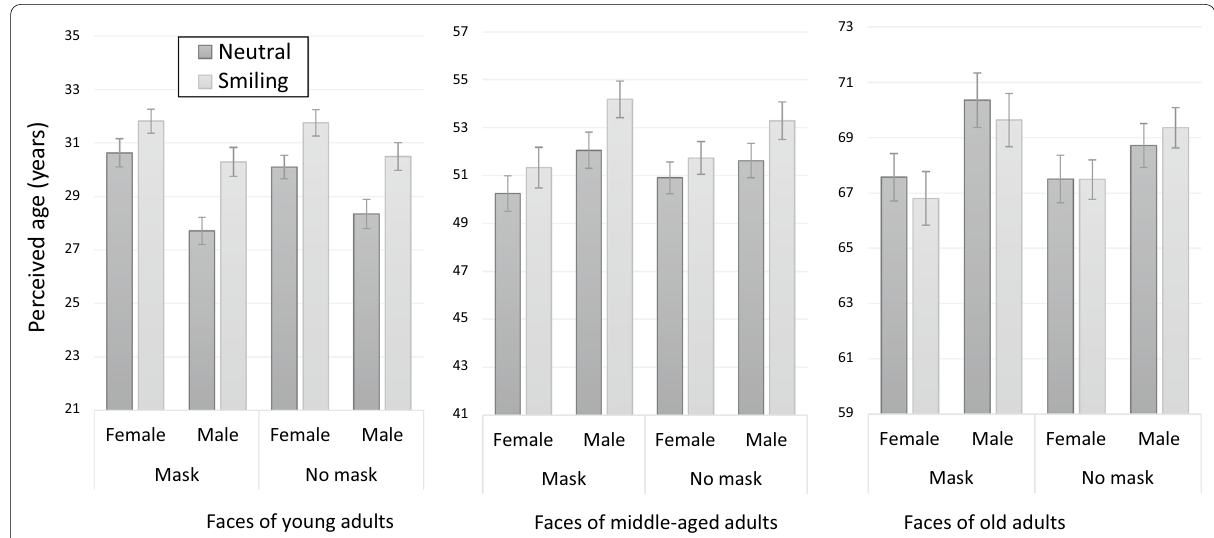
Fig. 2 The aging effect of smiling (AES) for masked and unmasked faces in Experiment 1. For unmasked faces, AES was found for male and for female faces in young adults, and for male faces in middle-aged adults. A similar pattern of results was found for masked faces, but now AES was also found for middle-aged female faces. Error bars represent standard errors of the